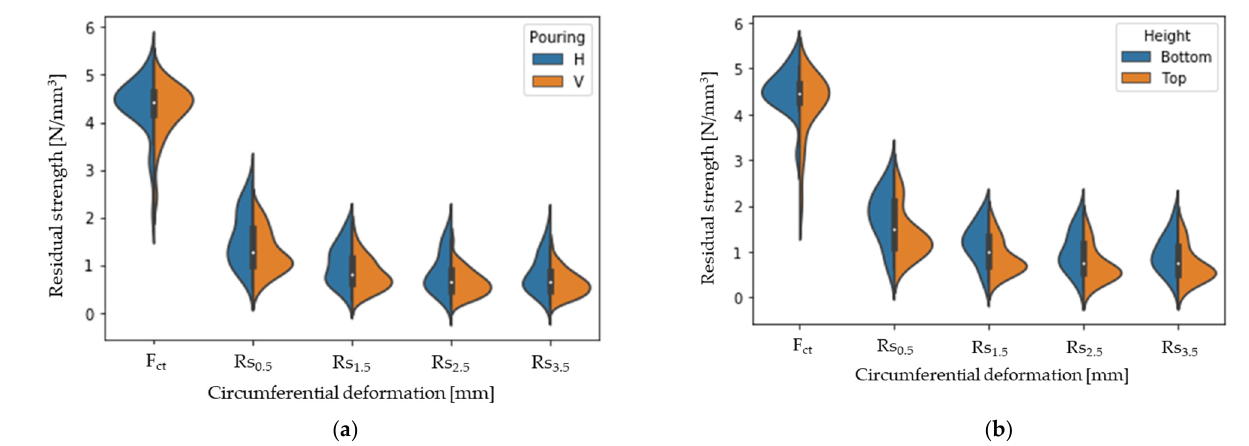
Figure 13. Distribution of the residual strength obtained by the BCN test as a function of the pouring